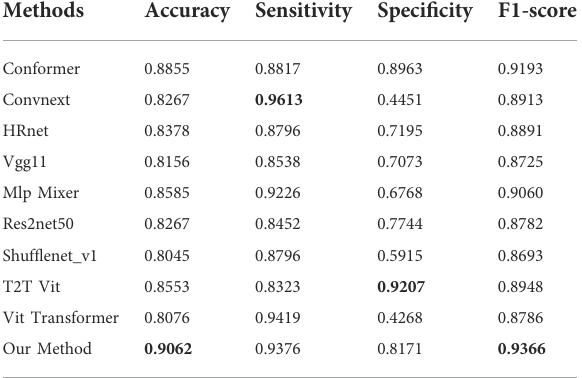
TABLE 1 Comparing the existing methods of binary classi fi cation for diabetic retinopathy.